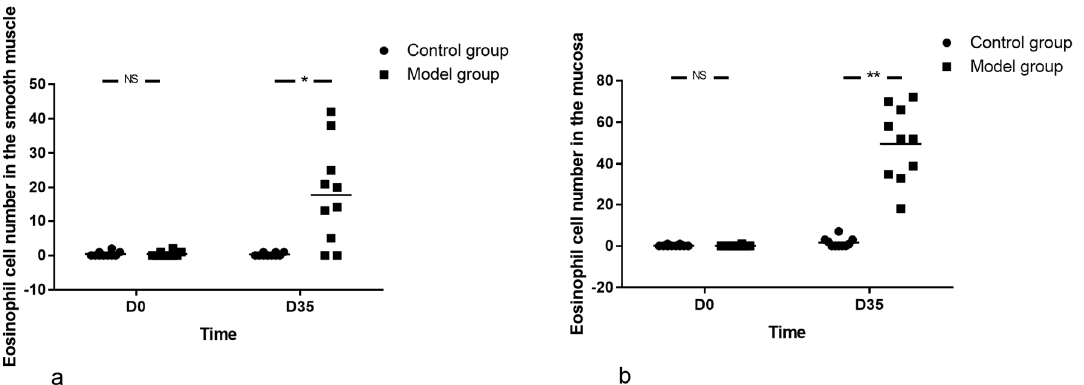
Figure 6. Esophageal histopathology of mice. ( a ) Eosinophil cell number in the smooth muscle and ( b ) Eosinophil cell number in the mucosa. There were almost no eosinophils in the esophagus at baseline in both groups by HE staining. The eosinophils in model group outnumbered that in control group with the prolongation of OVA treatment, in both mucosa and smooth muscle layer of esophagus. The number of mice in both groups was 10 at each time point. Mann-Whitney U-Test was used in comparison between groups and among different viewpoints in model group. * p < 0.05, ** p < 0.001, NS—not significant.